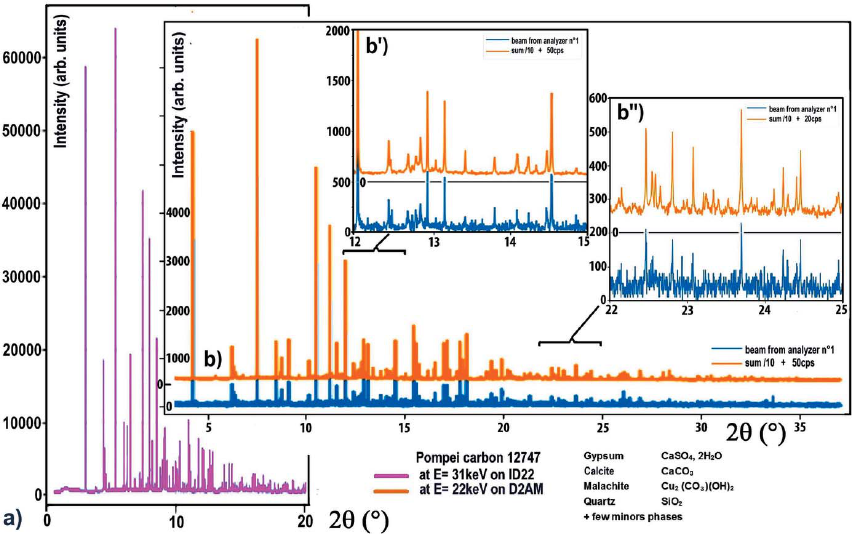
Figure 7 Comparison of powder diffractograms of archaeological samples found in the same bronze vessel from Pompeii, which were collected on the high-resolution powder ID22 beamline and on the D2AM beamline using the single-crystal-comb + Soller-collimator blocks + 2D photon-counting detector setup. ( a ) Diffractogram collected on the high-resolution powder beamline ID22 (pink curve). ( b ) Diffractogram collected on the beamline D2AM using the single-crystal-comb system; the blue curve corresponds to data from one single central channel of this single-crystal-comb and the orange curve uses the sum of its 20 channels. ( b 0 , b 00 ) Enlarged areas of this pattern highlight the mixture of a dozen phases including gypsum, calcite, malachite and